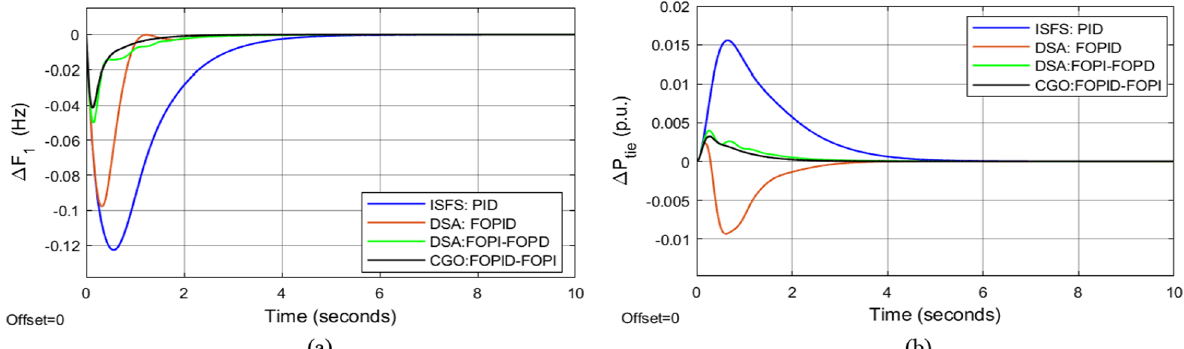
Fig. 11 Transient responses under 10% SLP in area 1 and 20% SLP in area 2: a ΔF 1 and b Δ P